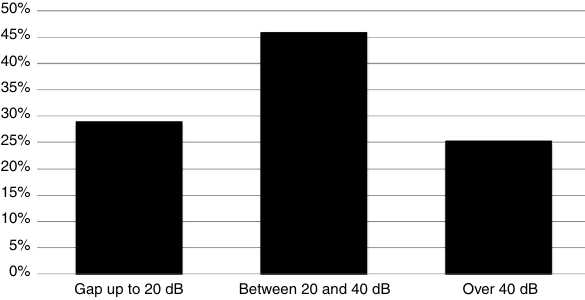
Figure 3 Prevalence of the air-bone difference sizes in tri- tonal means.